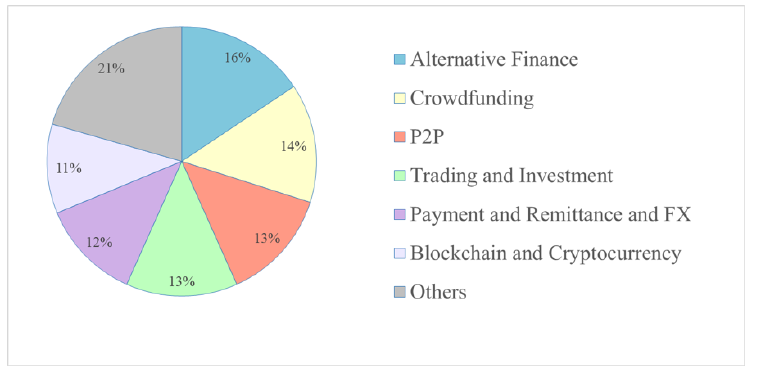
Figure 1. Segmentation of the Islamic fintech industry as of May 2021, % of companies. Source: own processing based on the statements of Global Islamic Economy Reports, DinarStandard.